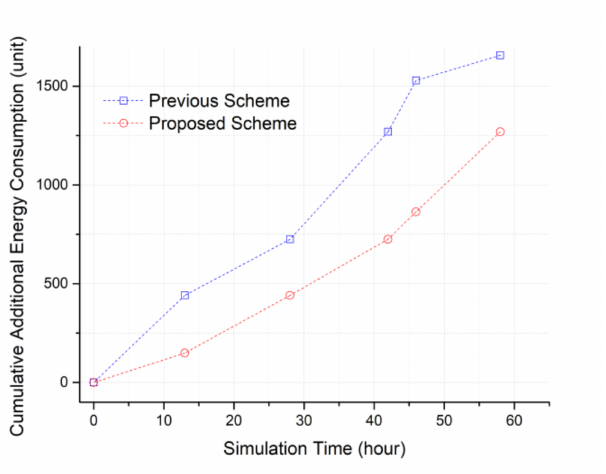
Figure 13. Cumulative additional energy consumptions to resolve the ping-pong states